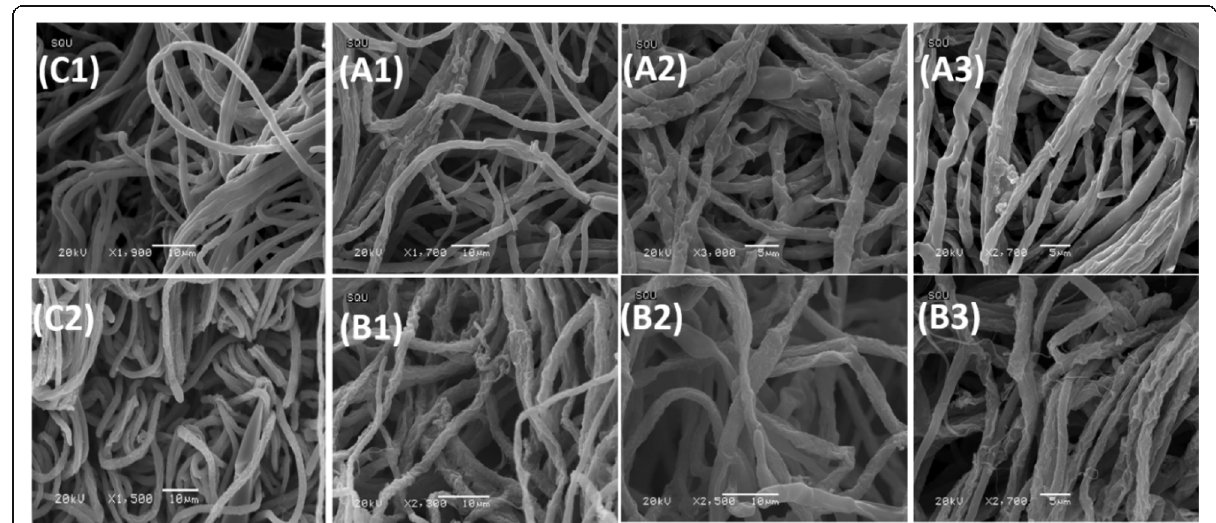
Fig. 2 Scanning electron micrographs showing morphological abnormalities in the hyphae of F. solani and Alternaria sp. due to the antagonistic effect of endophytic bacterial strains from date palm (cv. Nighal) (C1 and C2, control for F. solani and Alternaria , respectively; A1 – A3, F. solani exposed to B1, B7 and B8; B1 – B3, Alternaria sp. exposed to B1, B7 and B8)